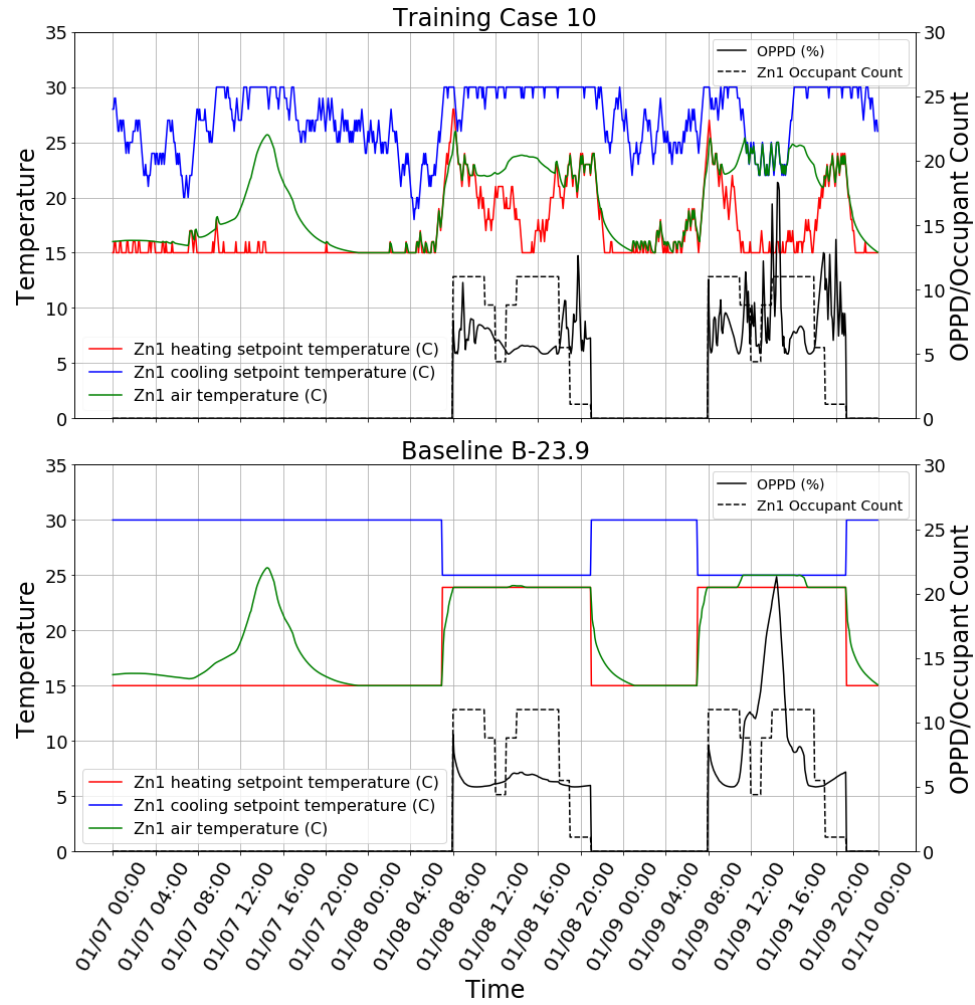
Figure 6. Training: control behavior snapshot of training case 10 ( top ) and the baseline case B-23.9 ( below ).